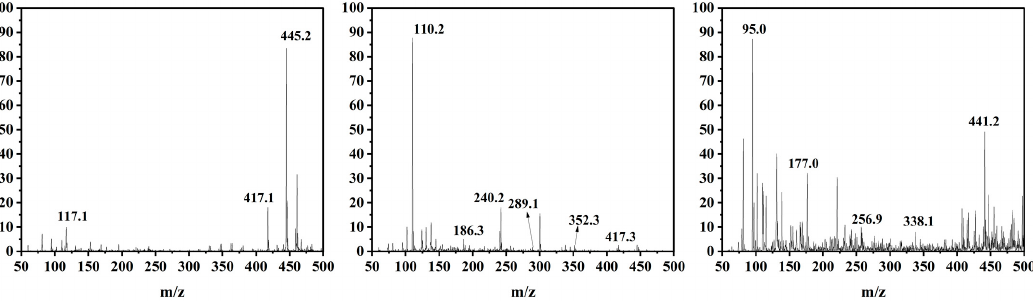
Figure 11. Mass spectra of tetracycline and its corresponding intermediates during photo-Fenton degradation of TC.